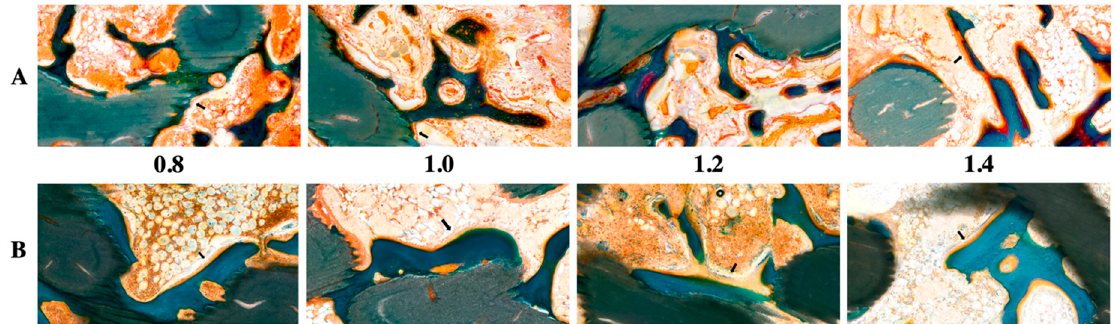
Figure 2. Histological evaluation of 3D-printed HA / TCP sca ff olds with pore sizes of 0.8, 1.0, 1.2, and 1.4 mm: ( A ) after four weeks (black arrow: osteoblast) and ( B ) after eight weeks (black arrow: osteoblast); green color: HA / TCP sca ff